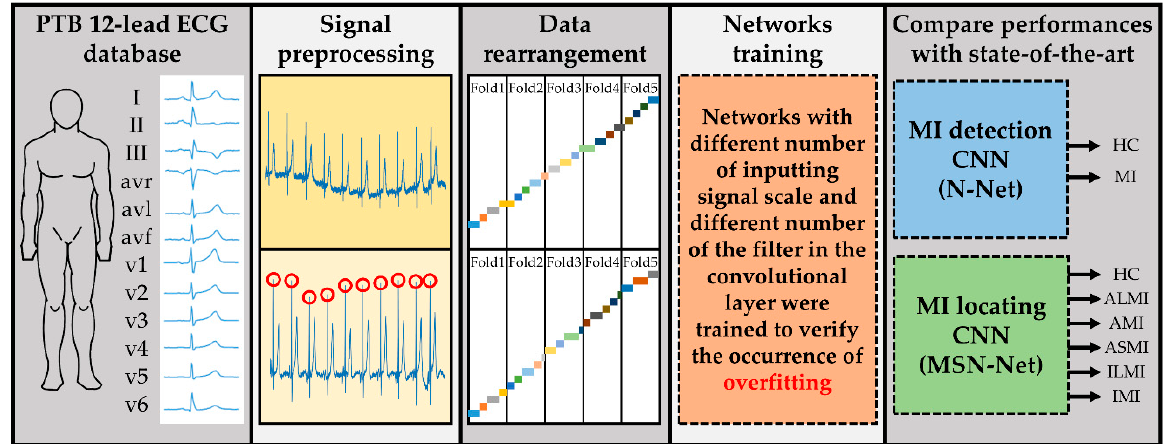
Figure 2. Block diagram of the research, including Physikalisch-Technische Bundesanstalt (PTB), 12-lead ECG database gathering, signal preprocessing, data rearrangement, study model networks training, and performance, compared with other studies. The final objective was to build models capable of detecting and/or locating the occurrence of MI by analyzing the 12-lead ECG.